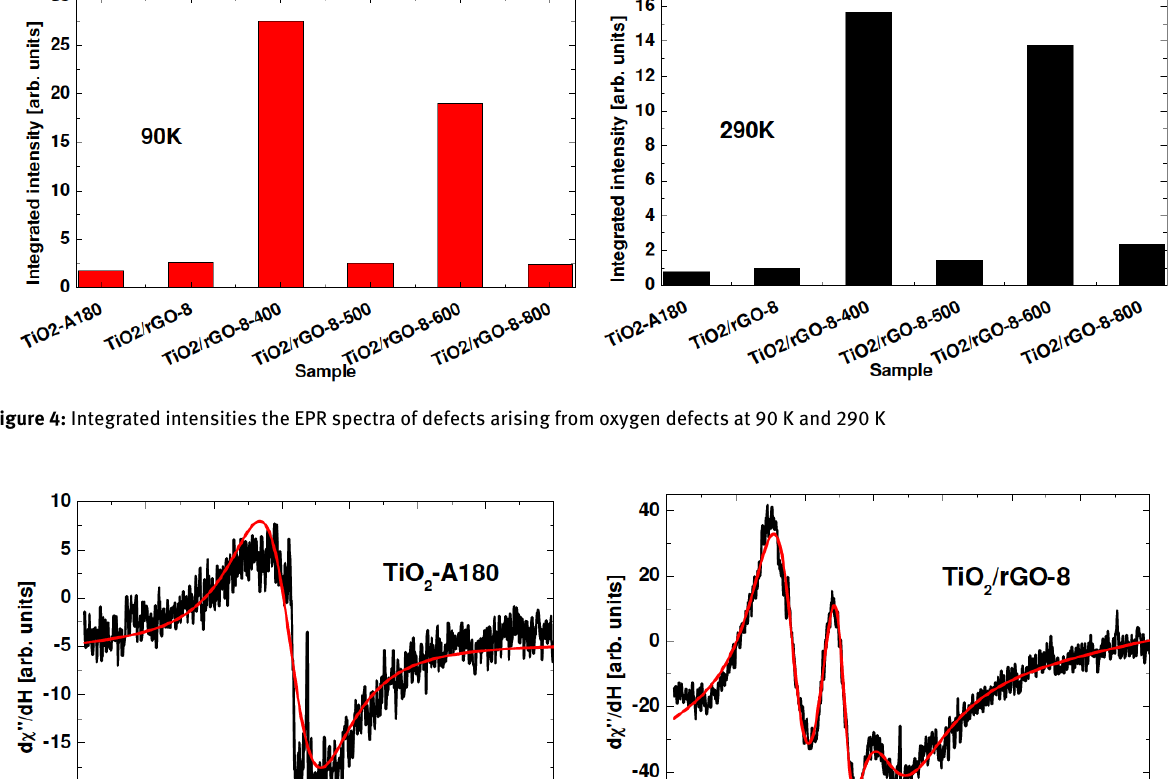
· µ ·(H – H ), where h and µ o r B eff